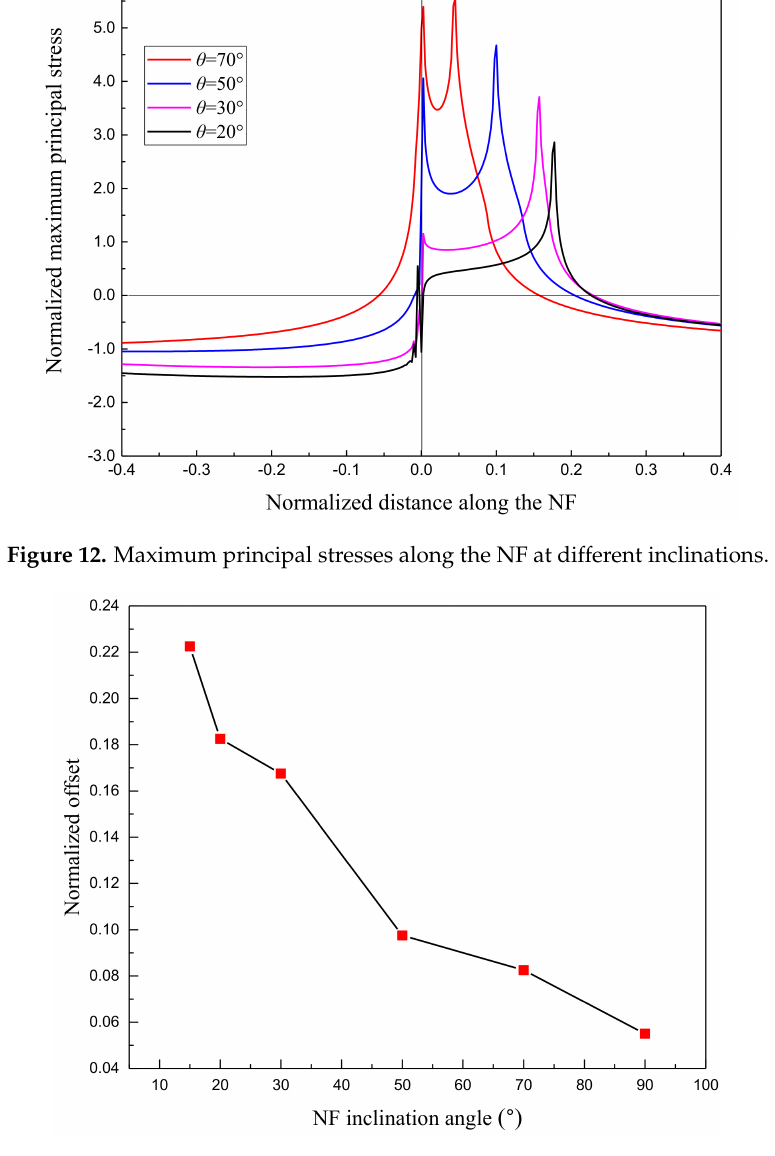
Figure 13. Offset of the maximum principal stress peak at different